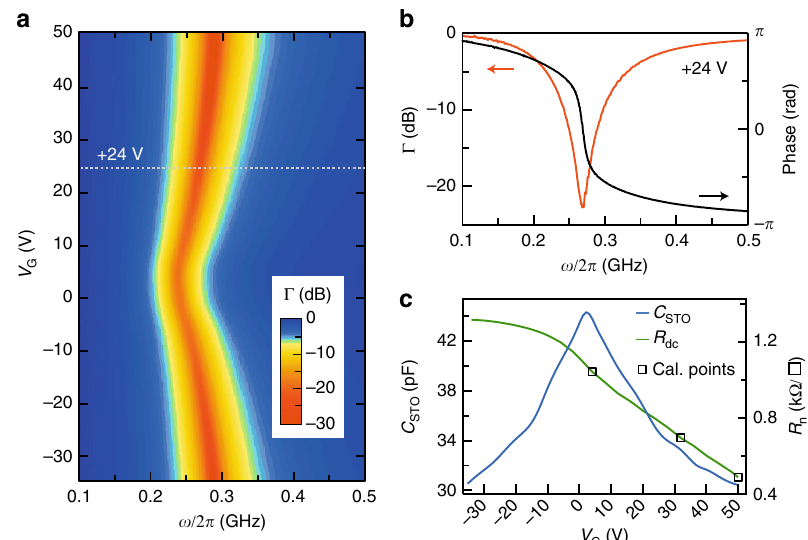
Fig. 2 Resonance of the sample circuit in the normal state at T = 450 mK. a Magnitude of Γ ( ω ) in dB (color scale) as a function of ω and V G . b Magnitude and phase of Γ ( ω ) at V G = +24 V. c Capacitance C STO extracted from the resonance frequency ω 0 ¼ 1 = (right axis) as a function of V G . Square symbols indicate the values of V G used for